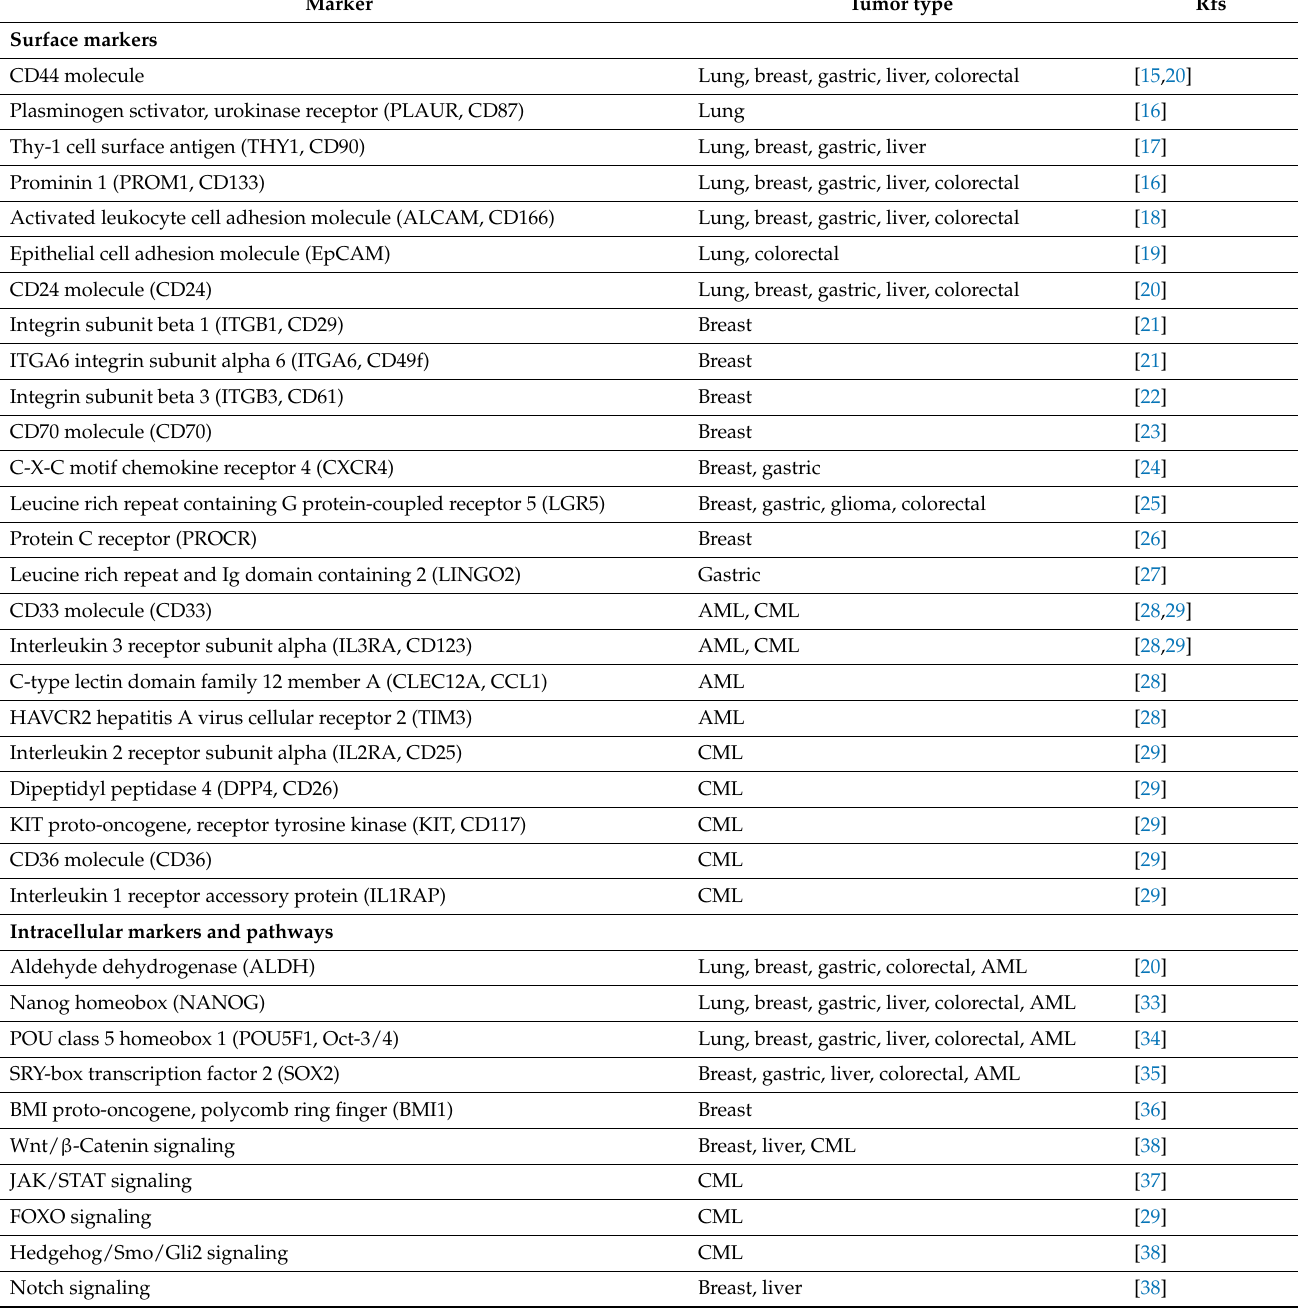
Table 1. CSC markers in different